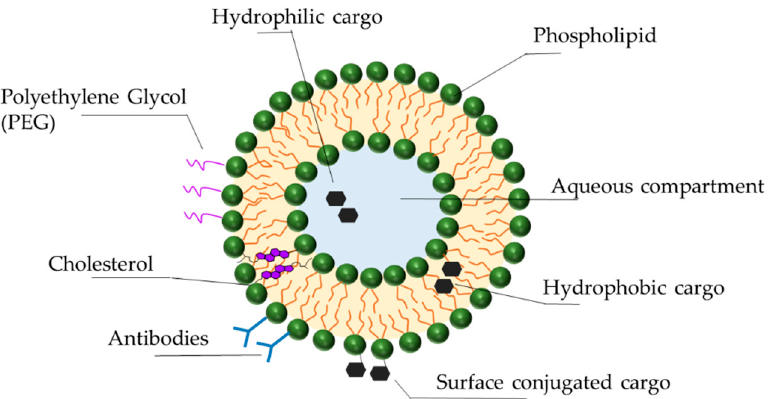
Figure 2. Liposomal delivery vehicles. Liposomes are spherical drug delivery vehicles made of a phospholipid bilayer with an aqueous core. Its hydrophobic and hydrophilic nature accommodates hydrophobic cargo in between the lipid layers and hydrophilic cargo in the aqueous compartment or conjugated to the external lipid polar headgroups. The polyethylene glycol (PEG) coating of liposomes prolongs their circulation by reducing uptake by macrophages. Surface labeling with antibodies promotes liposomal targeting to specific cells and cellular uptake. Cholesterol in the hydrophobic domain of the bilayers affects liposomal rigidity and permeability.